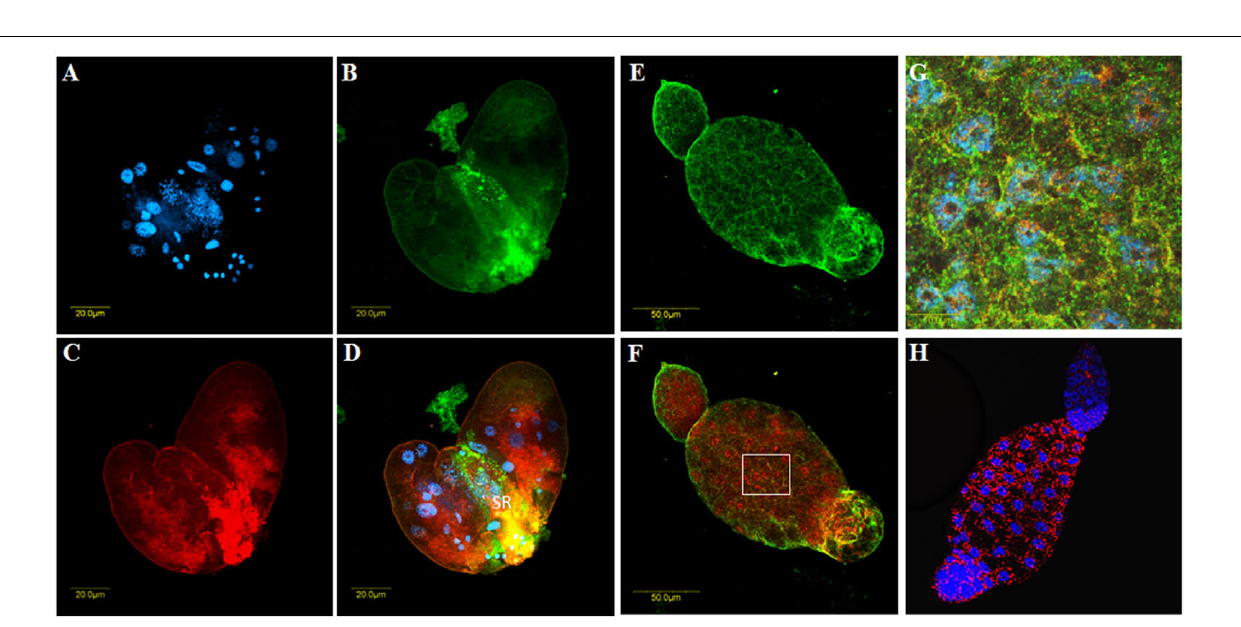
FIGURE 6 | Co-immunolocalization of TYLCV with first antibody against TYLCV CP of the virus, and detected with a secondary antibody conjugated to Cy3 (red), and first antibody against CypB detected with a secondary antibody conjugated to Cy2 anti-rabbit secondary antibody (green) in B. tabaci primary salivary glands (A–D) and in oocytes (E–H) dissected from viruliferous adults. (A) Shows one gland stained with DAPI for nuclei, (B) shows CypB immunolocalization, (C) shows TYLCV immunolocalization, and (D) is overlay of (A–C) showing the co-immunolocalization of CypB and TYLCV in the yellow portions near the secretory region of the primary salivary gland (SR). (E) shows one oocyte in which CypB is immunolocalized, (F) shows co-immunolocalization of TYLCV with CypB in the same oocyte, (G) is zoom in of the inset in (F) and (H) is a control oocyte in which the whole co-immunolocalization procedure was performed without adding the anti-CypB primary antibody. SR, secretory